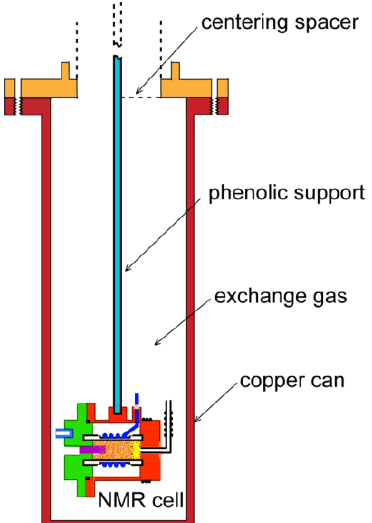
Figure 4. (Color on line) Schematic representation of the support structure and cooling path for the sample cell. The exterior copper can sits in a liquid helium bath that can be pumped to 1.4 K.